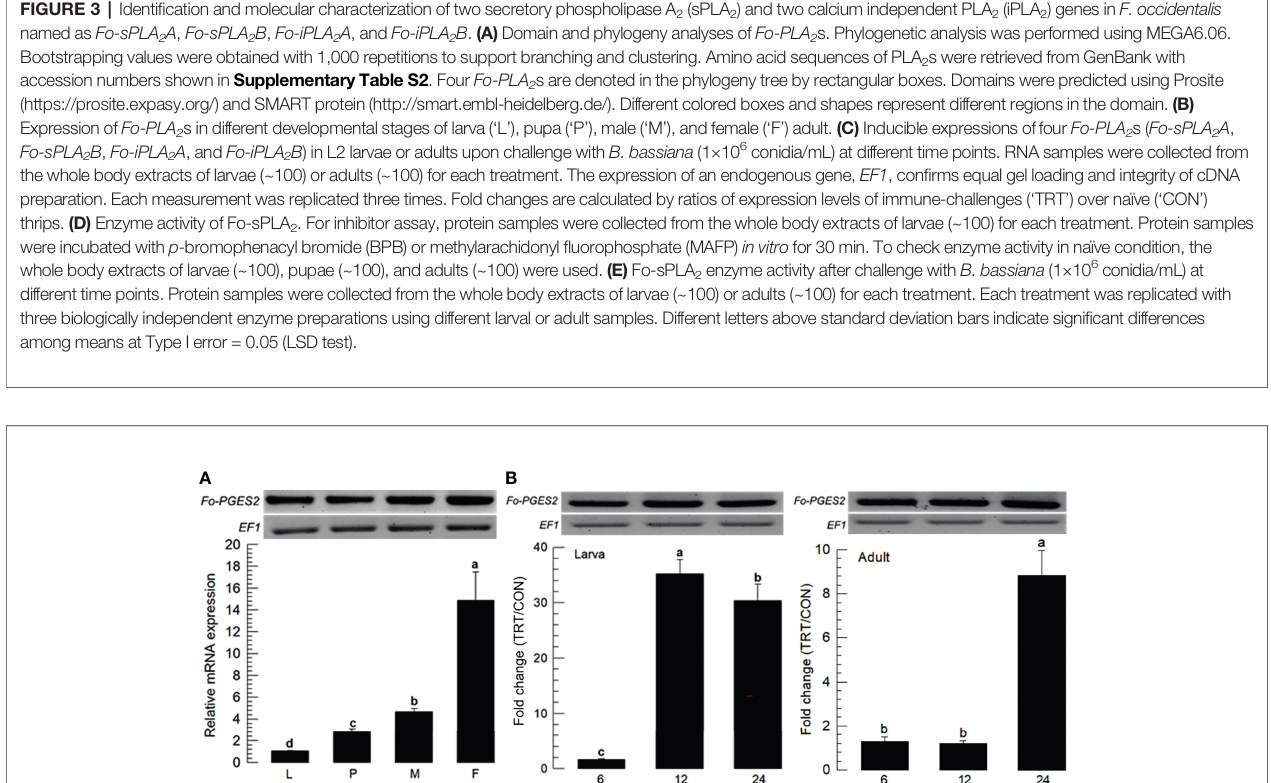
FIGURE 4 | Inducible expression of prostaglandin E2 synthase (PGES2) in F. occidentalis ( Fo-PGES2 ) upon fungal challenge. (A) Expression levels of Fo-PGES2 in different developmental stages of larva ( ‘ L ’ ), pupa ( ‘ P ’ ), male ( ‘ M ’ ), and female ( ‘ F ’ ) adult. (B) Inducible expression of Fo-PGES2 in L2 larvae or adults upon challenge with B. bassiana (1×10 6 conidia/mL) at different time points. RNA samples were collected from the whole body extracts of larvae (~100), pupae (~100), or adults (~100) for each treatment. The expression of an endogenous gene, EF1 , con fi rms equal gel loading and integrity of cDNA preparation. Each measurement was replicated three times. Fold changes are calculated by ratios of expression levels of immune-challenges ( ‘ TRT ’ ) over naïve ( ‘ CON ’ ) thrips. Different letters above standard deviation bars indicate signi fi cant differences among means at Type I error = 0.05 (LSD test).